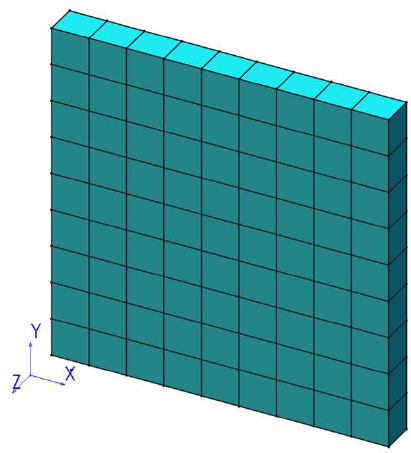
Figure 2. Finite element analysis model of the composite